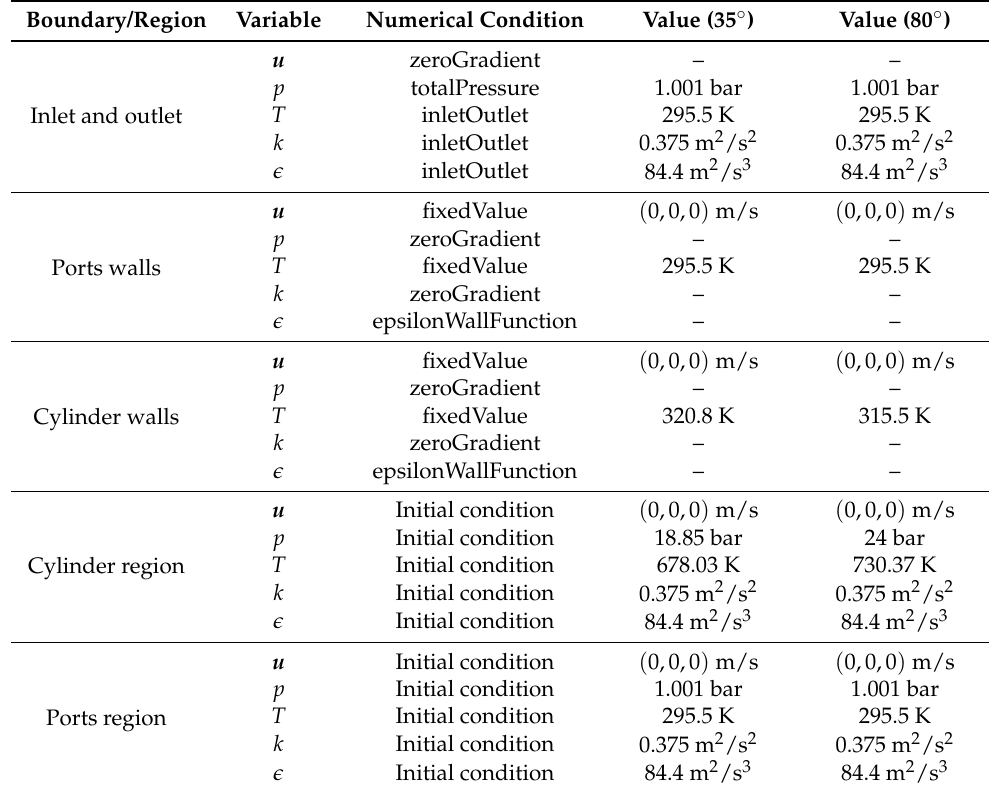
Table 3. Detail of boundary and initial